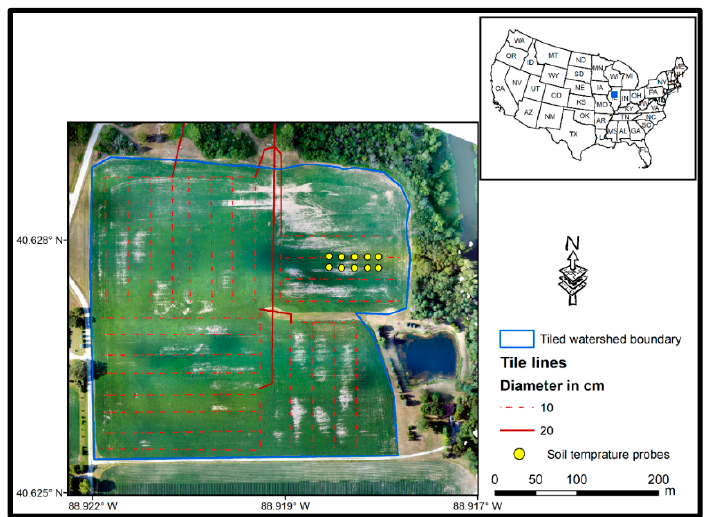
Figure 2. Location map of the study site, existing tile lines map (red lines), location of soil temperature probes (yellow circles) and background is orthomosaic image collected using Unmanned Aerial System (UAS).